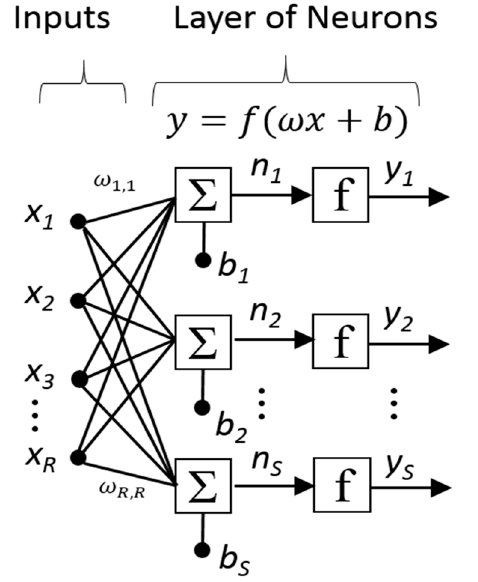
Figure 6. Structure of artificial neural network (ANN).